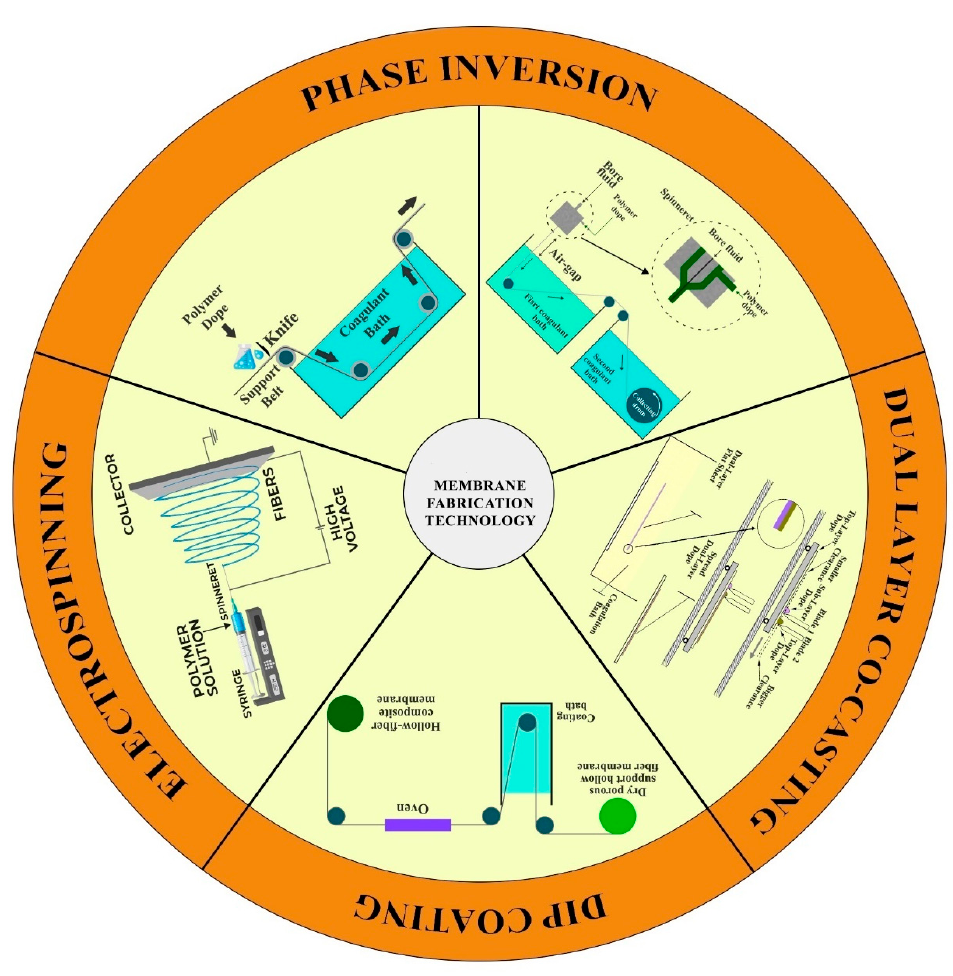
Figure 4. Various membrane-fabrication approaches.